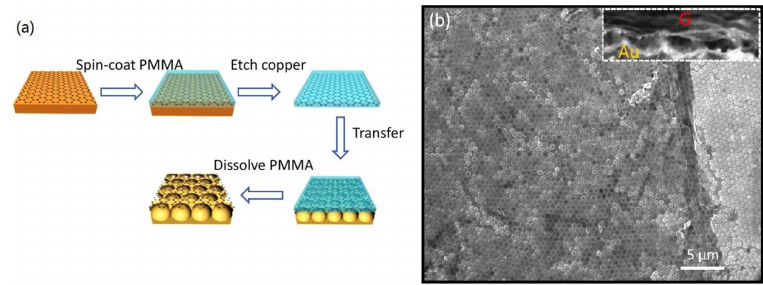
Figure 2. ( a ) Schematic illustrations of the graphene transfer process. ( b ) SEM image of a large-area nanovoid array integrated with the transferred monolayer graphene. The dark region is covered by graphene. The inset shows a SEM image of the cross-section of graphene-covered nanovoids. Reproduced from [58] with permission; Copyright ACS 2013.